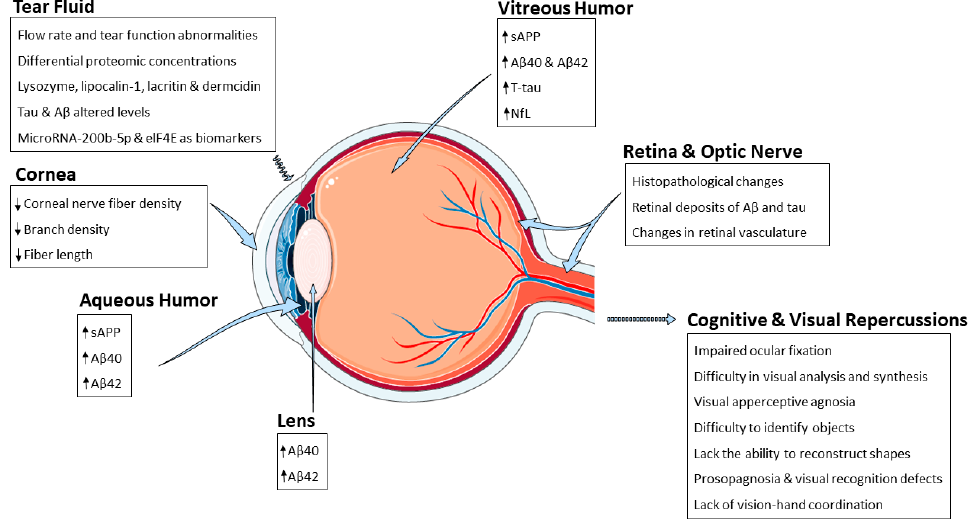
Figure 1. Schematic representation summarizing the AD-related alterations reported so far and the different eye structures affected by such changes. Abbreviations: amyloid- β peptide (A β ), eukaryotic initiation factor 4 e (eIF4E), neurofilament light chain (NfL), soluble amyloid precursor protein (sAPP).